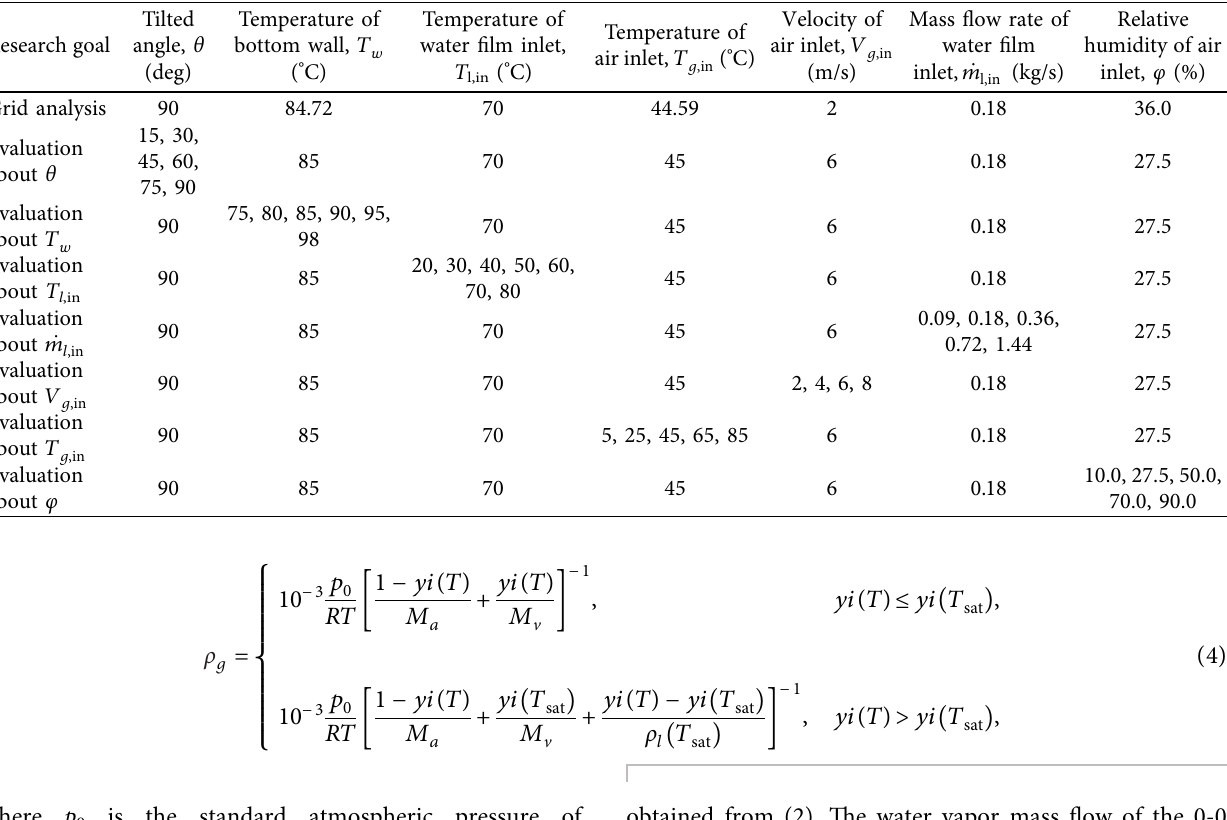
Table 1: Numerical simulation